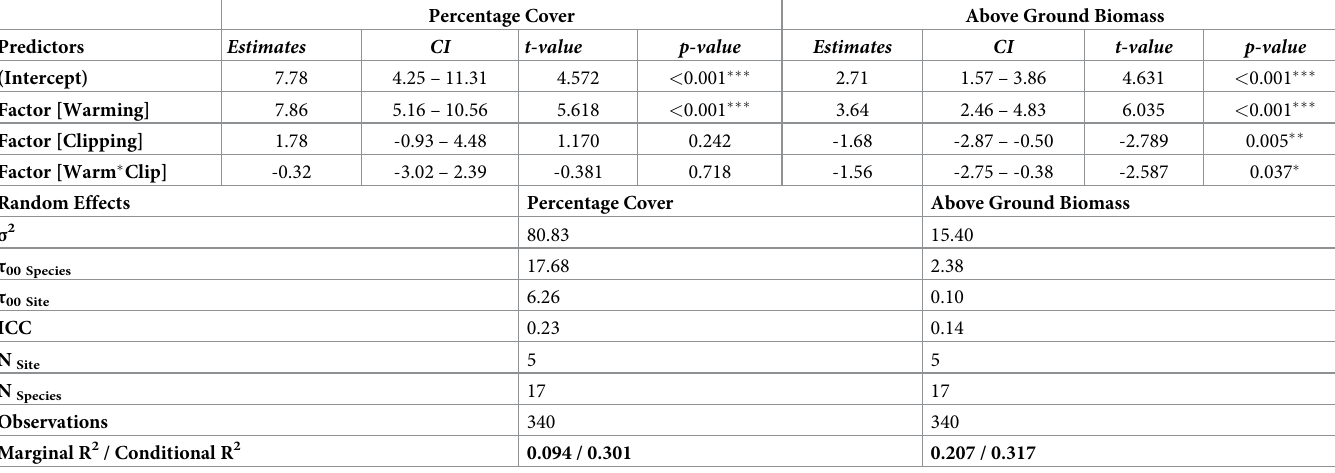
Table 2. Summary statistics of linear mixed model to determine the fixed effects of treatments and random effects of site &